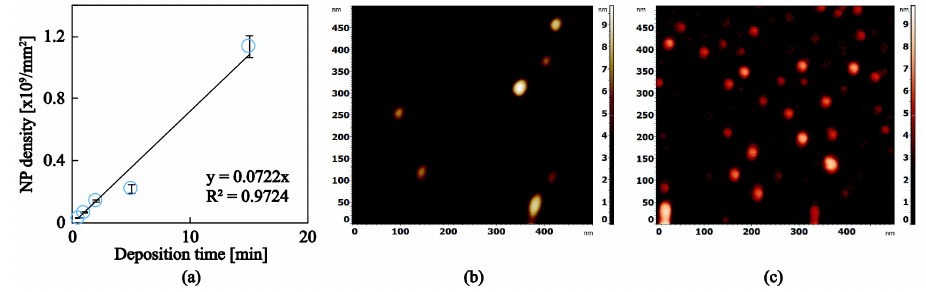
Figure 5. ( a ) Ag nanoparticle density for various deposition times; results relate to the samples shown in Table 2. AFM image of a ( b ) low deposition time and ( c ) high deposition time. Table 2. Deposition conditions for 4 nm nominal diameter Ag NPs grown at various durations and 0